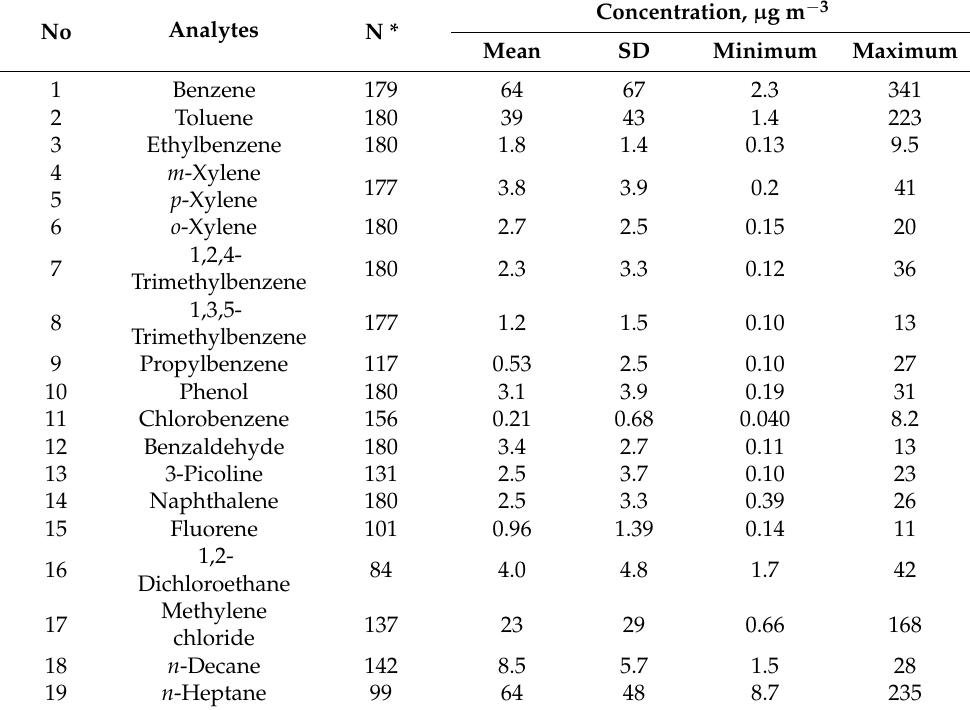
Table 3. Descriptive statistics of the VOC concentrations during the study